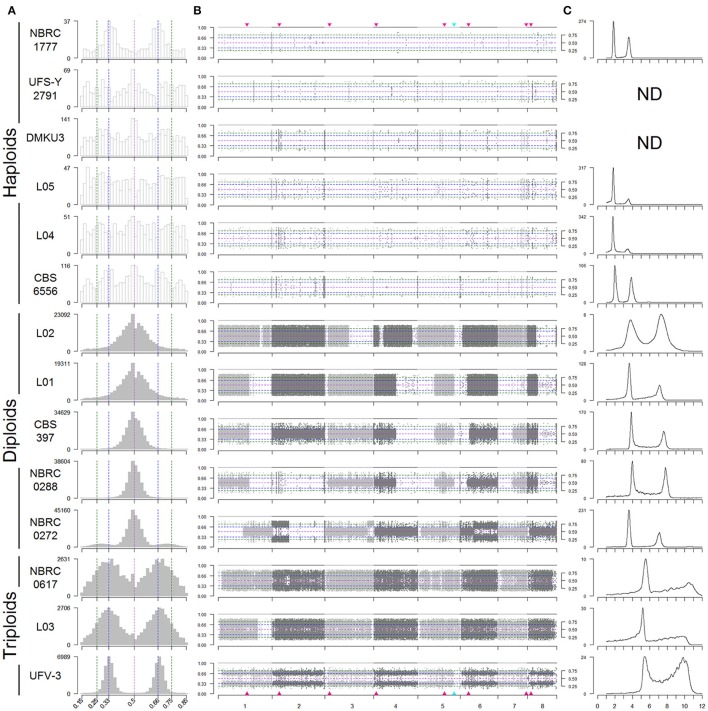
Variable ploidy in Kluyveromyces marxianus strains. Strain names are shown on the left. (A) Histograms of the alternative allele frequencies of variant (non-reference) bases, for SNPs designated as heterozygous (sites with alternative allele frequencies fB between 0.15 and 0.85). Histograms are coloured grey if at least 10% of the SNPs in a strain are heterozygous. Dashed vertical lines mark frequencies of 0.5 (purple), 0.33/0.66 (blue), and 0.25/0.75 (green). Bin sizes are 2% intervals. (B) Plots of alternative allele frequencies along the 8 chromosomes, for each strain. Horizontal dashed lines mark frequencies as in (A). Light and dark gray points indicate SNPs on different chromosomes. Red triangles mark the locations of centromeres, and the blue triangle marks the ribosomal DNA locus. Allele frequencies ≥ 0.85 are shown as 1. Alternative allele frequencies ≤ 0.15 are not shown. (C) Flow cytometry of DNA content. The Y-axis shows numbers of cells, and the X-axis shows SYTOX Green fluorescence signal intensity (arbitrary units) which is proportional to DNA content. Flow cytometry was not carried out for UFS-Y2791 and DMKU3-1042.